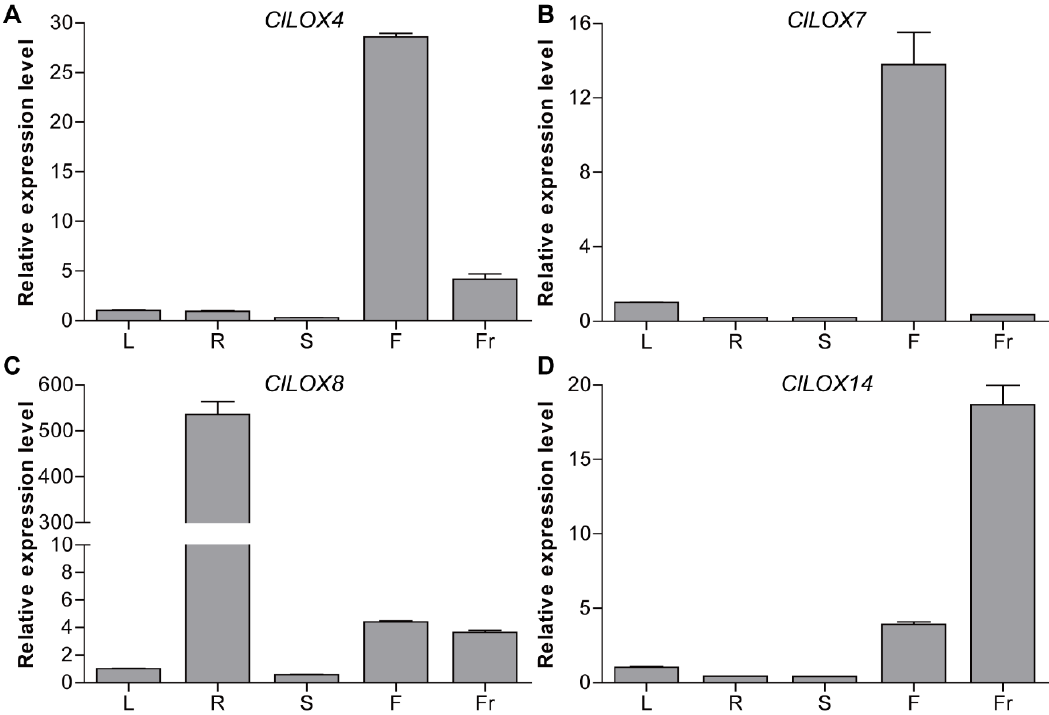
Figure 6. qRT-PCR analysis of the expression of selected ClLOX genes ( A – D ) in different watermelon tissues. L, leaves; R, roots; S, stems; F, flowers; Fr, fruit. Error bars indicate standard deviation (SD) based on three biological replicates.